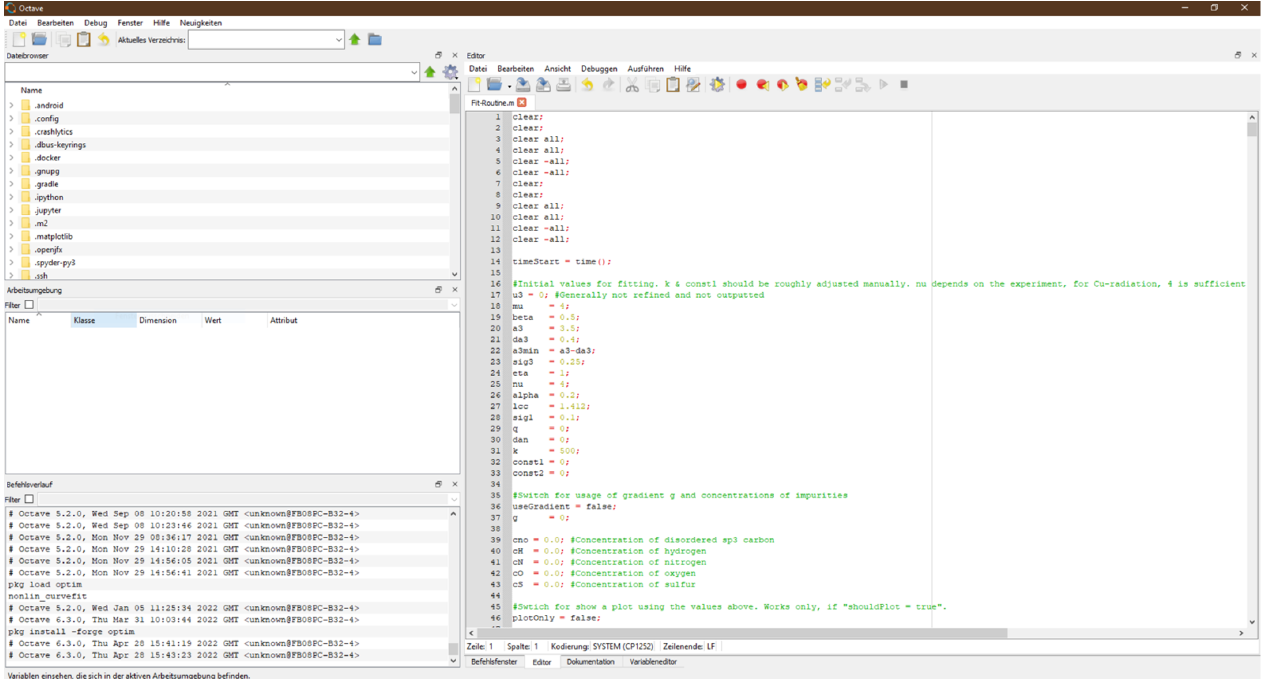
Figure 3. Main graphical user interface (GUI) of Octave and the OctCarb refinement script (main window). On the top bar, the Octave files (*.m) can be opened and saved, and various windows can be activated and deactivated. On the left side, the current working directory can be changed, and the currently used variables and executed commands are shown. On the lower side, one can switch between the Command Window (e.g., the Octave Command User Interface), the Editor (to edit the script files) and the Variable Editor and Documentation .